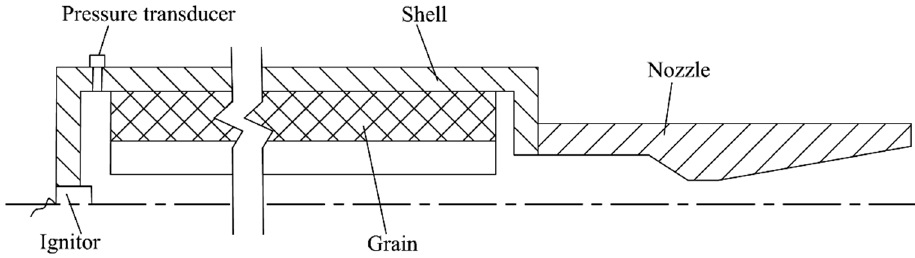
Figure 4. Schematic of the